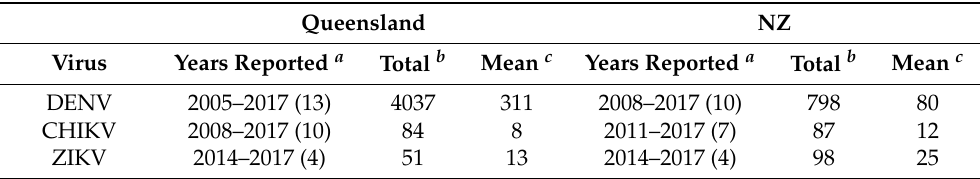
Table 2. Number of notifications of DENV, CHIKV, and ZIKV reported per year from Queensland (2005–2017) and New Zealand (NZ)